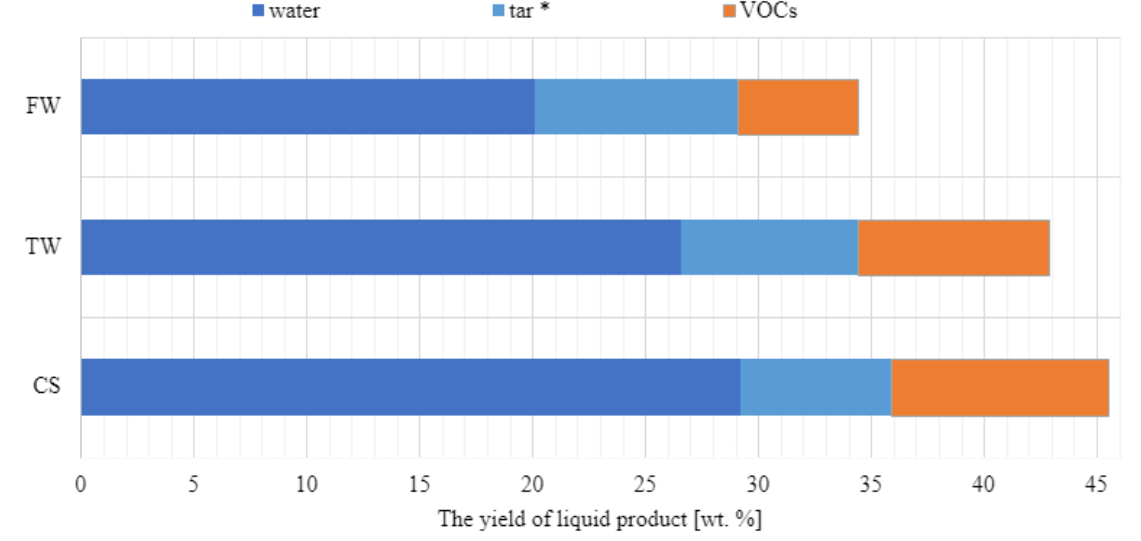
Figure 5. Pyrolysis of waste biomass results in a variable liquid product yield distribution (CS, TW, and FW). Evaporation of the residue to a constant mass of liquid products (at 0.1 bar, 65 °C), allowing for the determination of tar concentration (*).